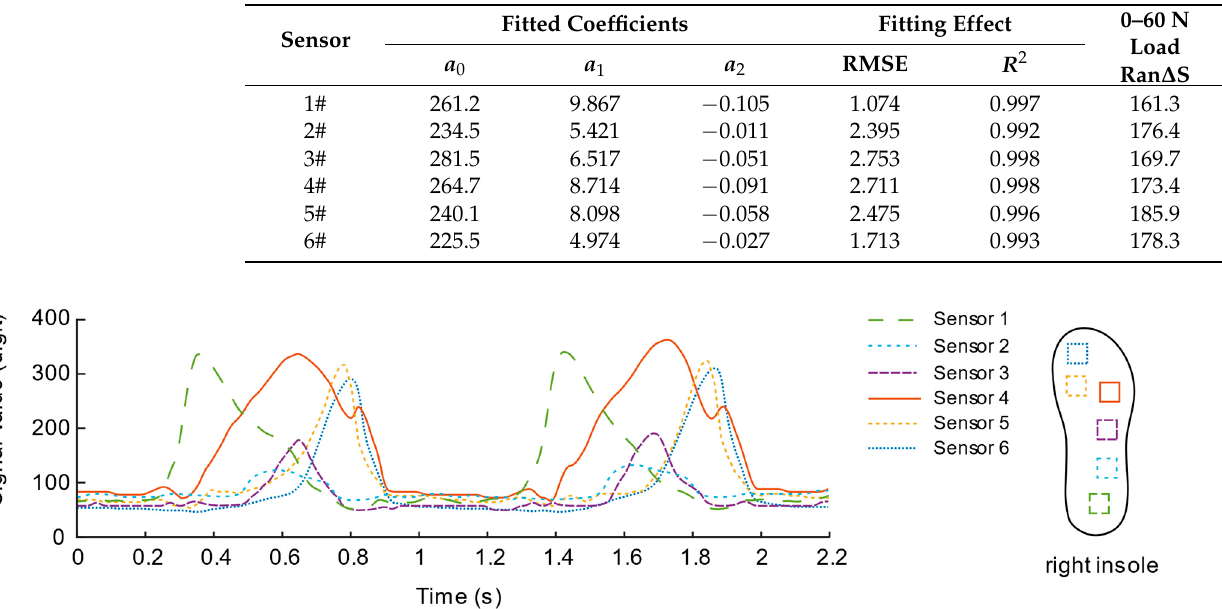
Figure 11. Signal Curve of the second insole solution.